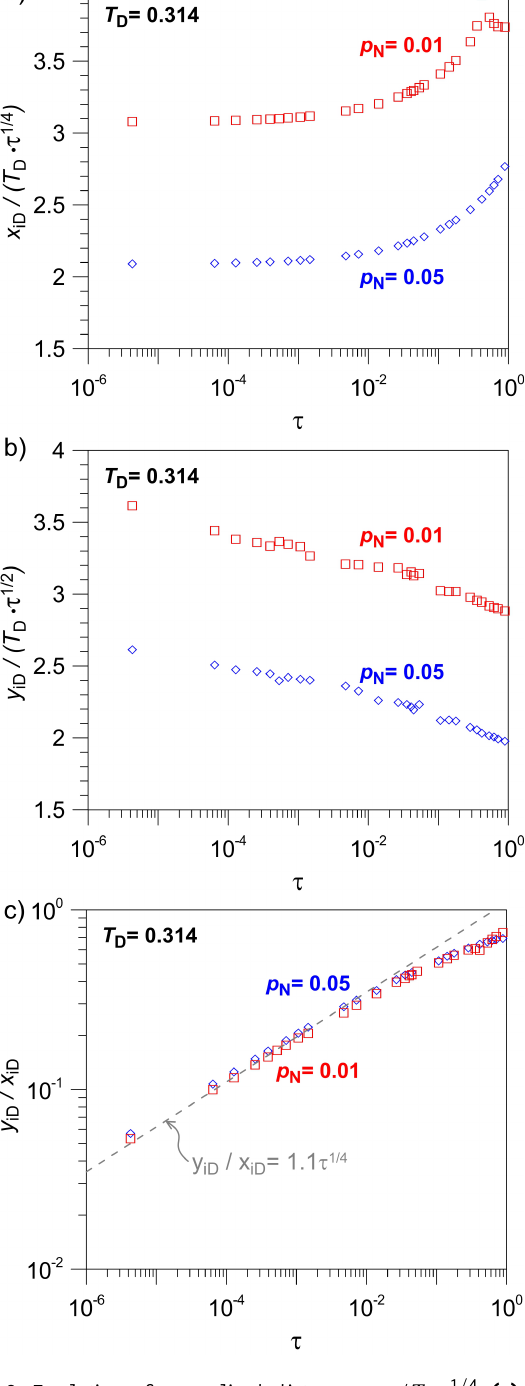
Fig. 6. Evolution of normalized distances x iD /T D τ 1 / 4 (a) and y iD /T D τ 1 / 4 (b) , and of the ratio y iD /x iD (c) as functions of dimen- sionless time τ for normalized isobars p N = 0 . 01 and p N = 0 . 05. Dimensionless fracture conductivity is T D = 0 . 314 in all cases. For τ < 10 − 2 the normalized distance x iD /T D τ 1 / 4 is approximately constant and equal to α b introduced in Eqs. (12) and (13) and cal- culated from Fig.